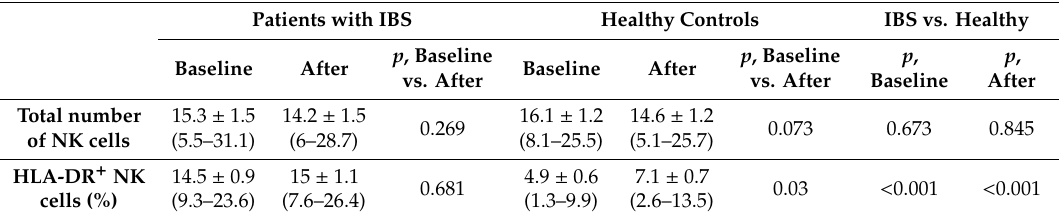
Table 1. Total number and percentage of activated natural killer (NK) cells at baseline and after oral administration of a product comprising lactobacilli supplemented with larch arabinogalactan and colostrum in healthy controls and patients with IBS. Patients with IBS Healthy Controls IBS vs. Healthy p , Baseline p , Baseline p , p , Baseline After Baseline After vs. After Baseline After vs. After